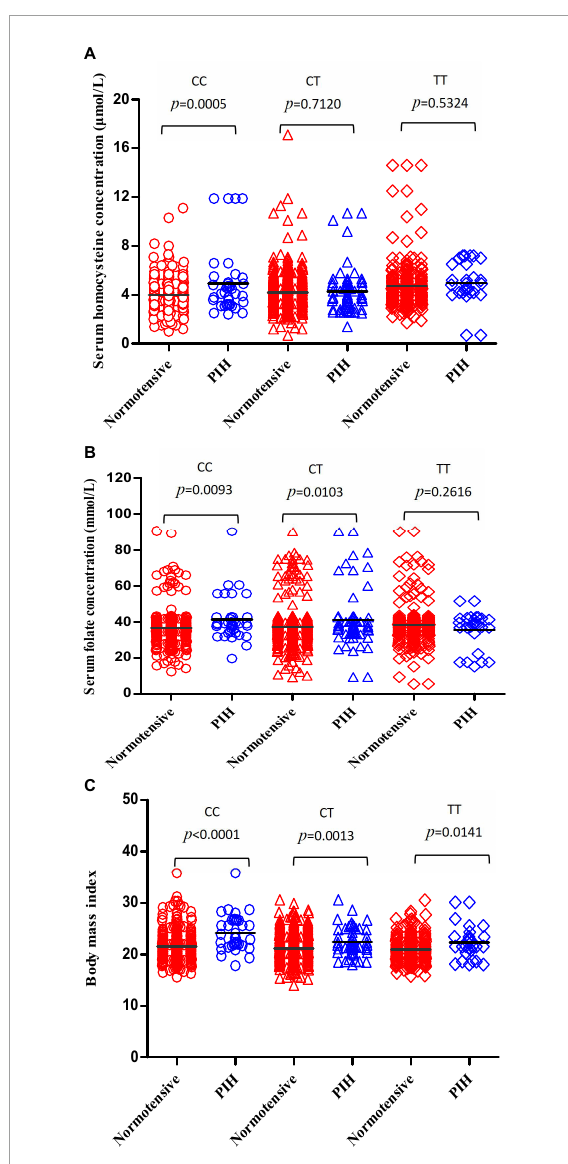
FIGURE3 Compare the differences in serum homocysteine concentration, serum concentration, and BMI between the normotensive pregnancy group and PIH group in subgroups carrying different MTHFR C677T genotypes. (A) Compare the differences in serum homocysteine concentration between the normotensive pregnancy group and PIH group in subgroups carrying different MTHFR CC, CT, and TT genotypes, respectively. (B) Compare the differences in serum folate concentration between the normotensive pregnancy group and PIH group in subgroups carrying different MTHFR CC, CT, and TT genotypes, respectively. (C) Compare the differences in BMI between the normotensive pregnancy group and PIH group in subgroups carrying different MTHFR CC, CT, and TT genotype, respectively.